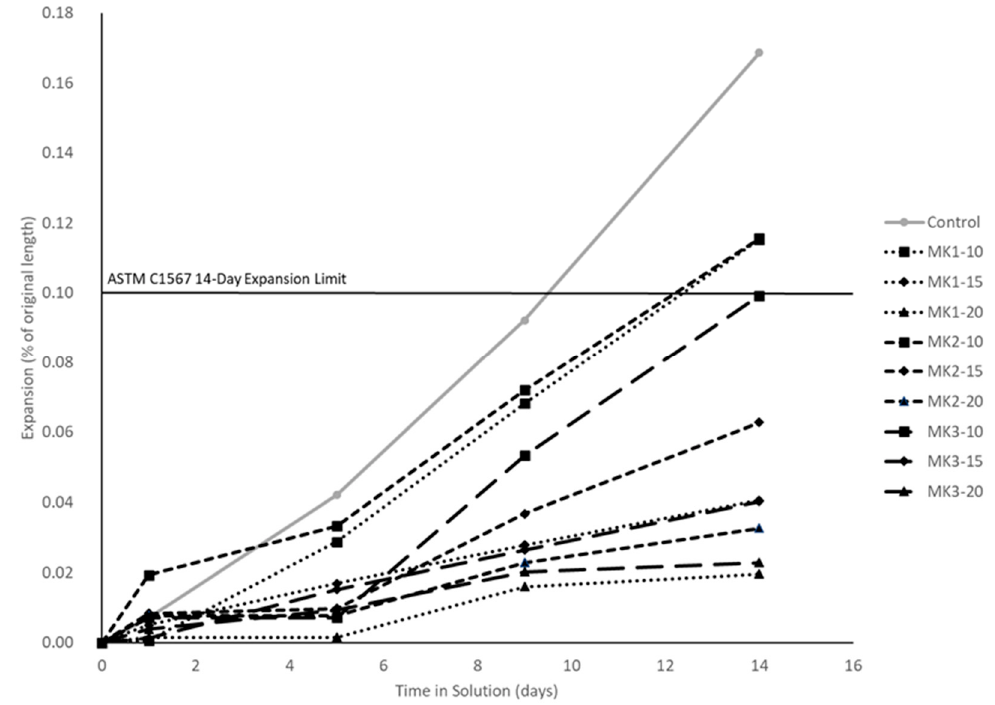
Figure 7. Expansion of metakaolin mortars immersed in aqueous NaOH solution.